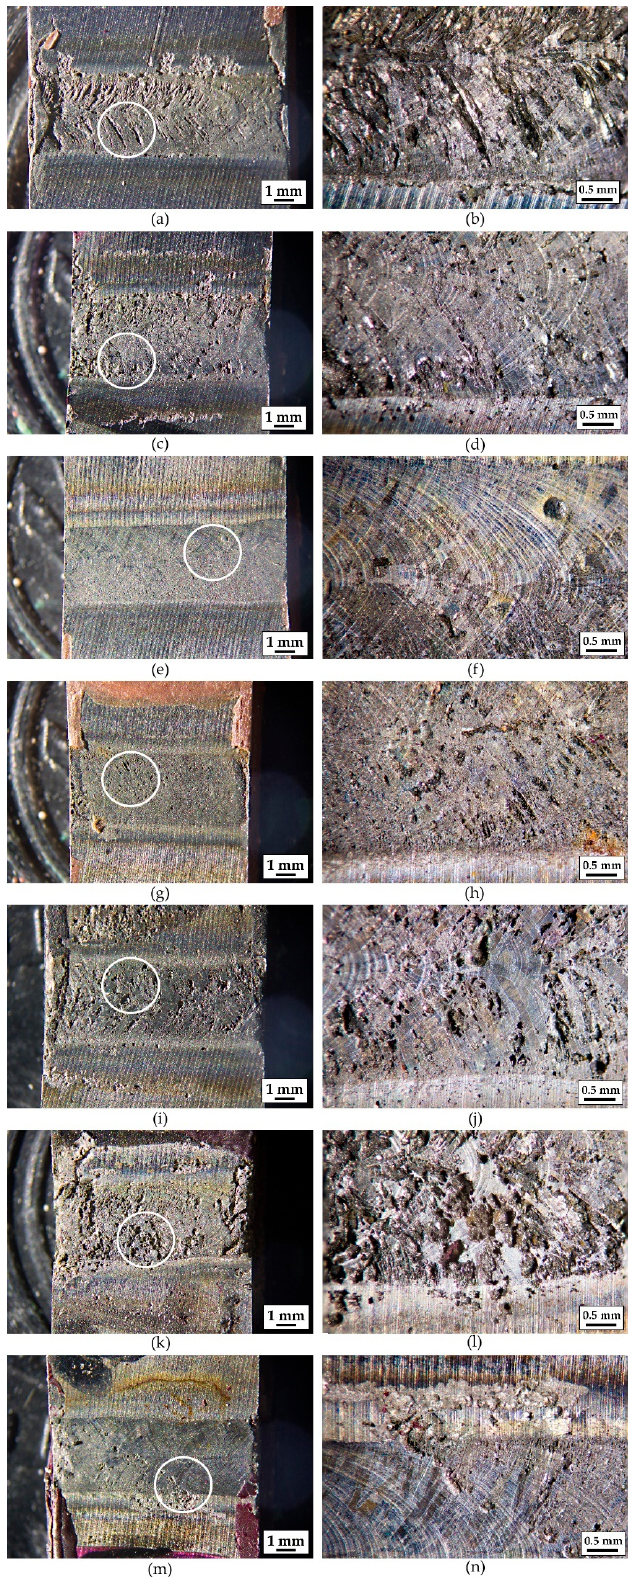
Figure 11. Pits location on the welded sample after CPT tests: ( a , b ) undeformed; ( c , d ) 9.6% thickness reduction; ( e , f ) 21.1% thickness reduction; ( g , h ) 29.6% thickness reduction; ( i , j ) 39.4% thickness reduction; ( k , l ) 49.9% thickness reduction; and ( m , n ) 60.3% thickness reduction. Right column images are higher magnification of the highlighted area of the pictures on the left